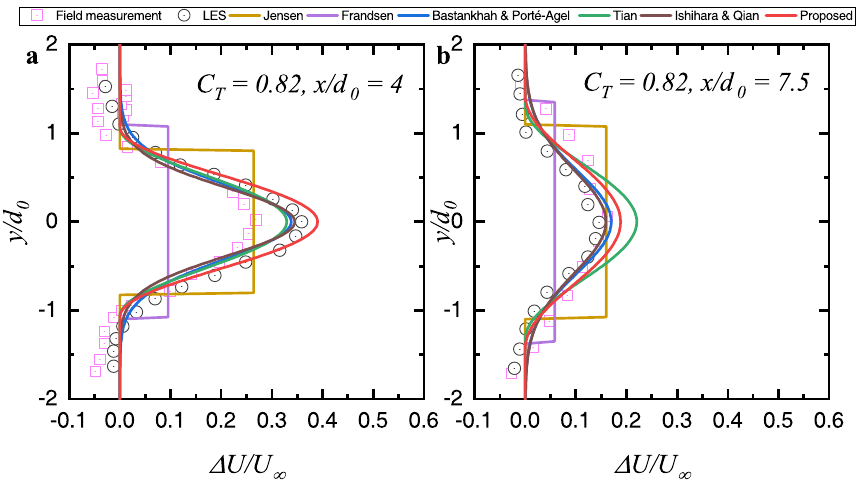
Figure 7. Comparison between the field measurement data and the predicted normalized velocity deficit: ( a ) C T = 0.82, x / d 0 = 4; ( b ) C T = 0.82, x / d 0 =